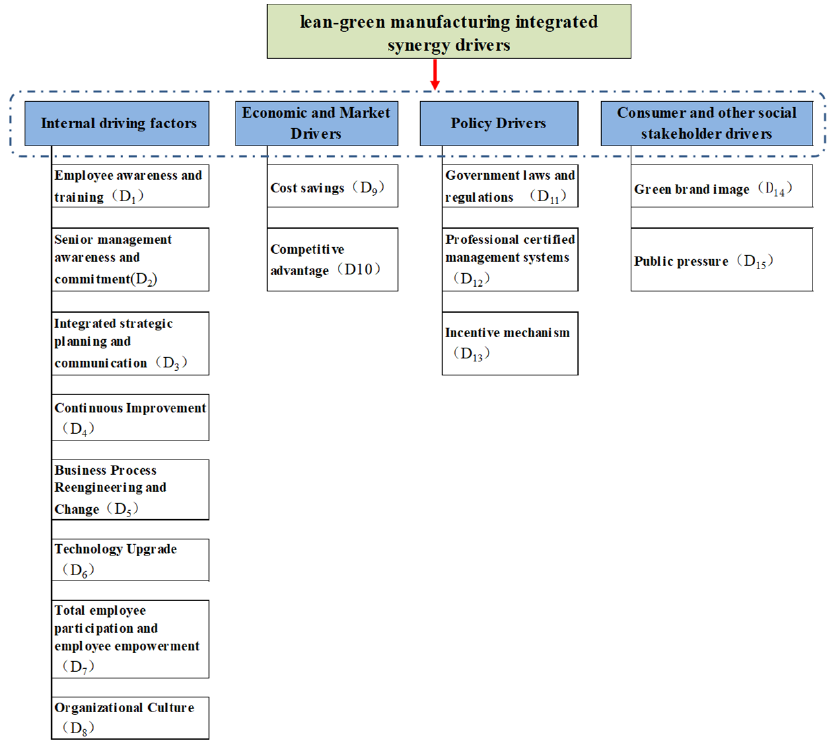
Figure 1. Classification of lean-green manufacturing integrated synergy drivers.